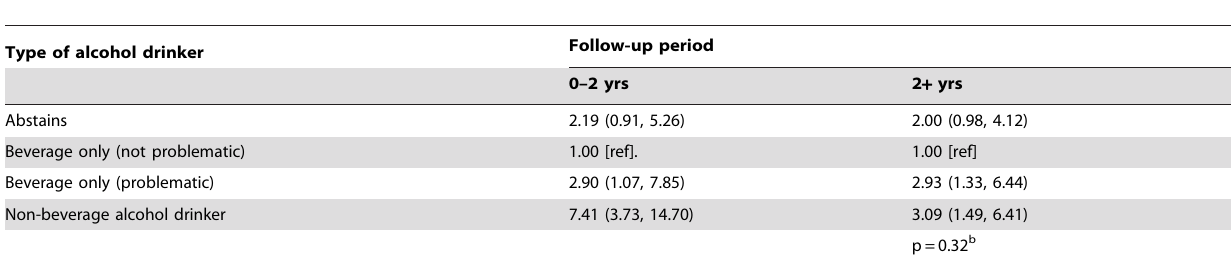
Table 3. Adjusted a mortality hazard ratios (95% confidence intervals) by proxy reported type of alcohol drinking and follow-up